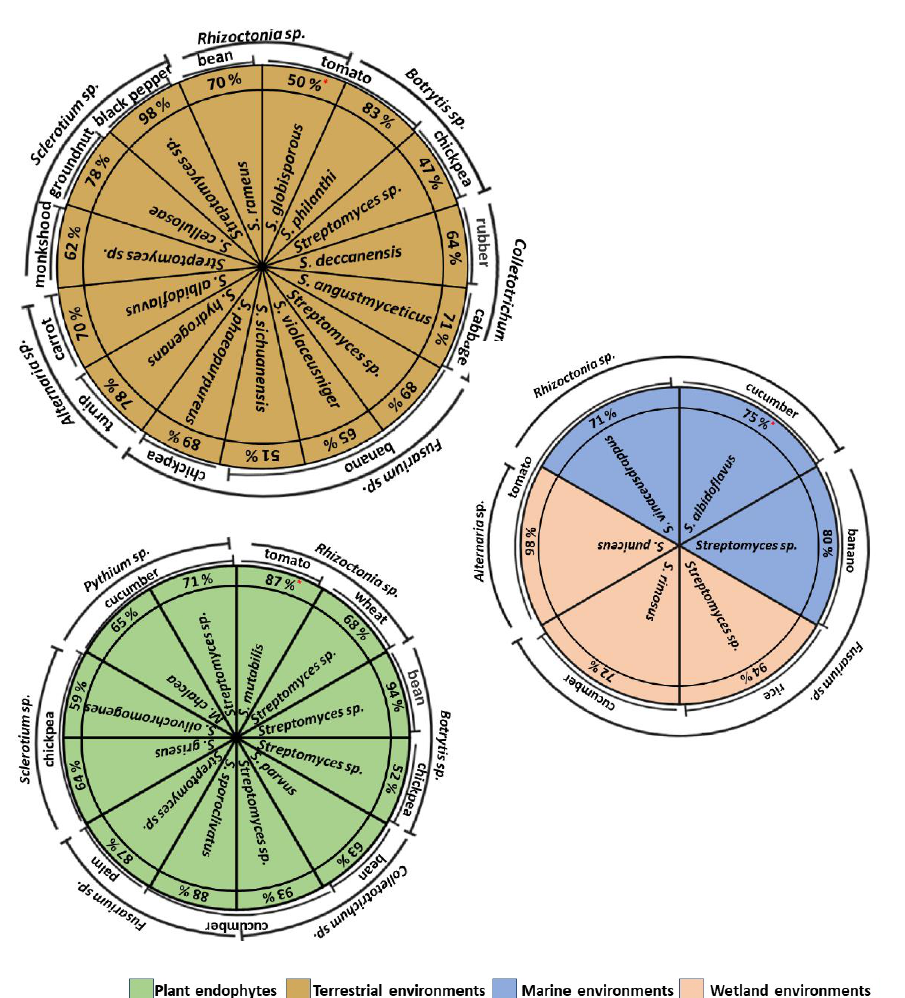
Figure 3. Antifungal activity (% growth inhibition * ) of actinomycetes in vivo isolated from different environments [1,4,10,21,25,29,59,60,63,69 – 71,73,74,77,78,80,83,85,87 – 97].